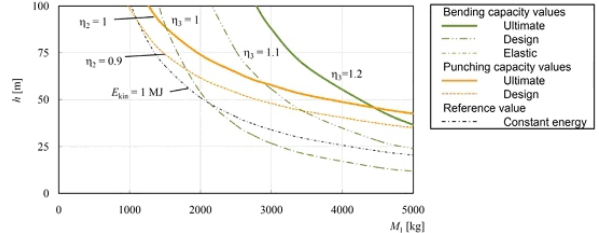
Fig. 16. Loading capacity of protection gallery Axen-S¨ud for dif- ferent impact masses (from Schellenberg, 2009).